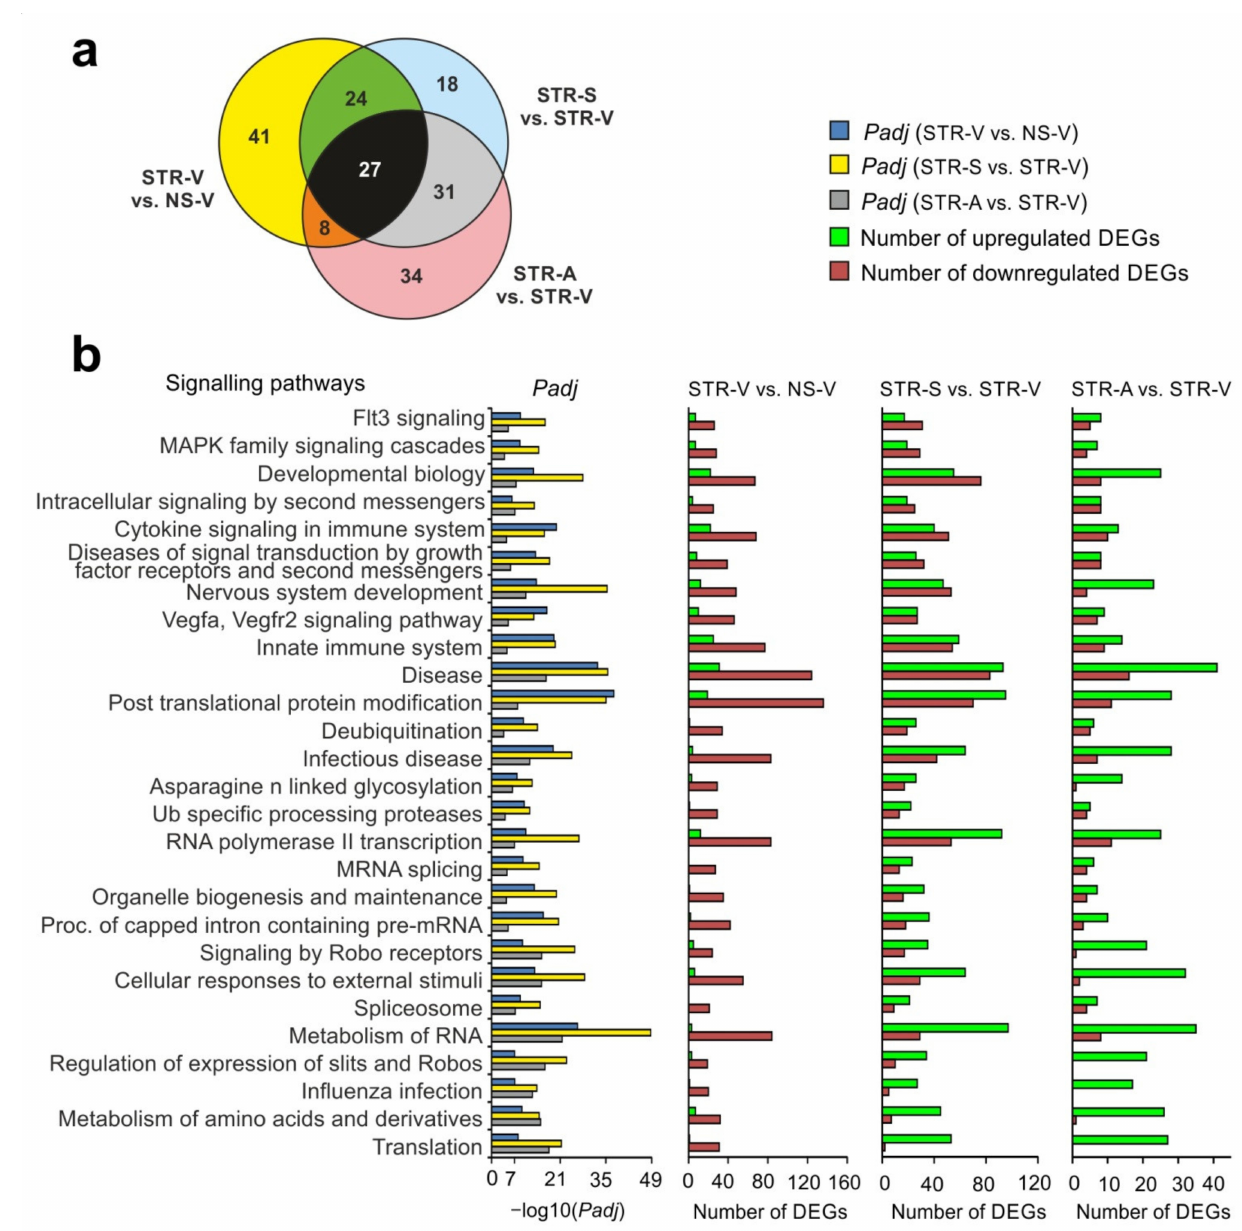
Figure 4. Analysis of the signaling pathways associated with DEGs under ARS and peptide treatment conditions. ( a ) The number of overlapping signaling pathways in the three pairwise comparisons, STR-V vs. NS-V, STR-S vs. STR-V, and STR-A vs. STR-V. ( b ) Functional annotation of DEGs in the three pairwise comparisons, STR-V vs. NS-V, STR-S vs. STR-V, and STR-A vs. STR-V was conducted according to the GSEA database. The number of up- and downregulated DEGs, as well as the Padj , are shown. Only those genes and signaling pathways with Padj < 0.05 were selected for